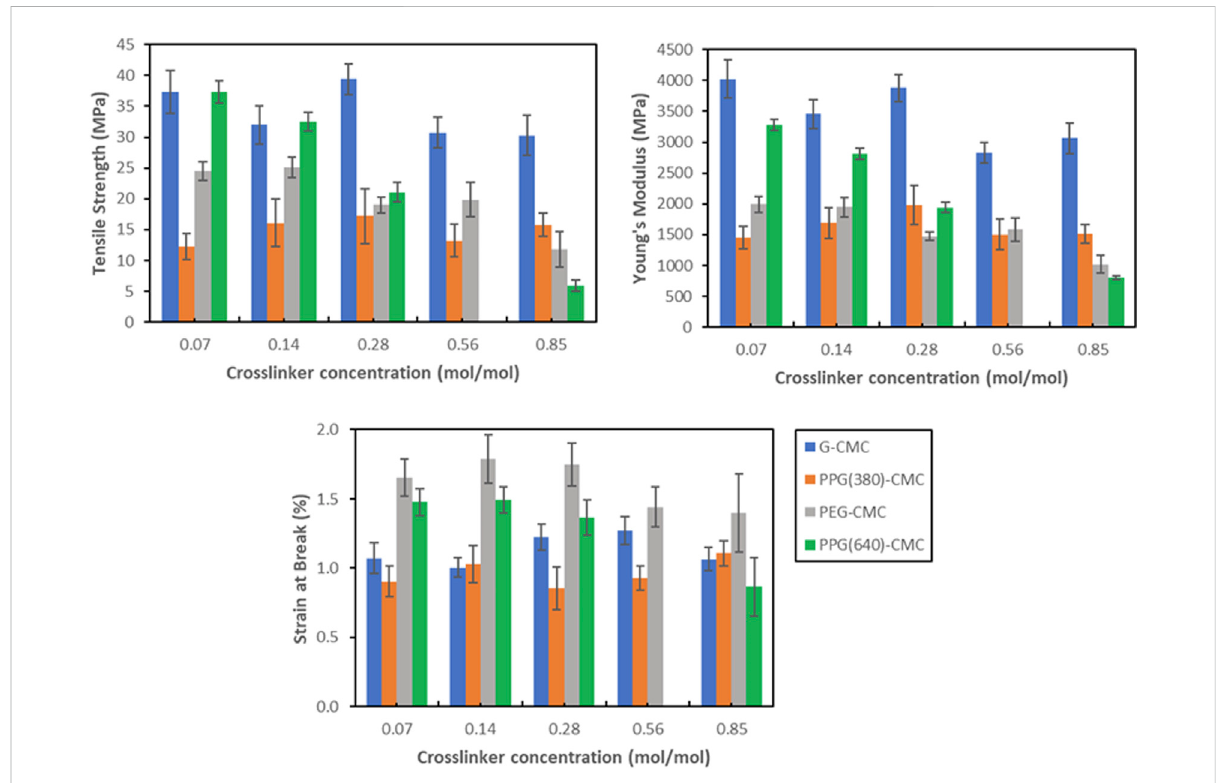
FIGURE 9 Tensile results for each CMC-DE polymer. Errors are given as standard error of